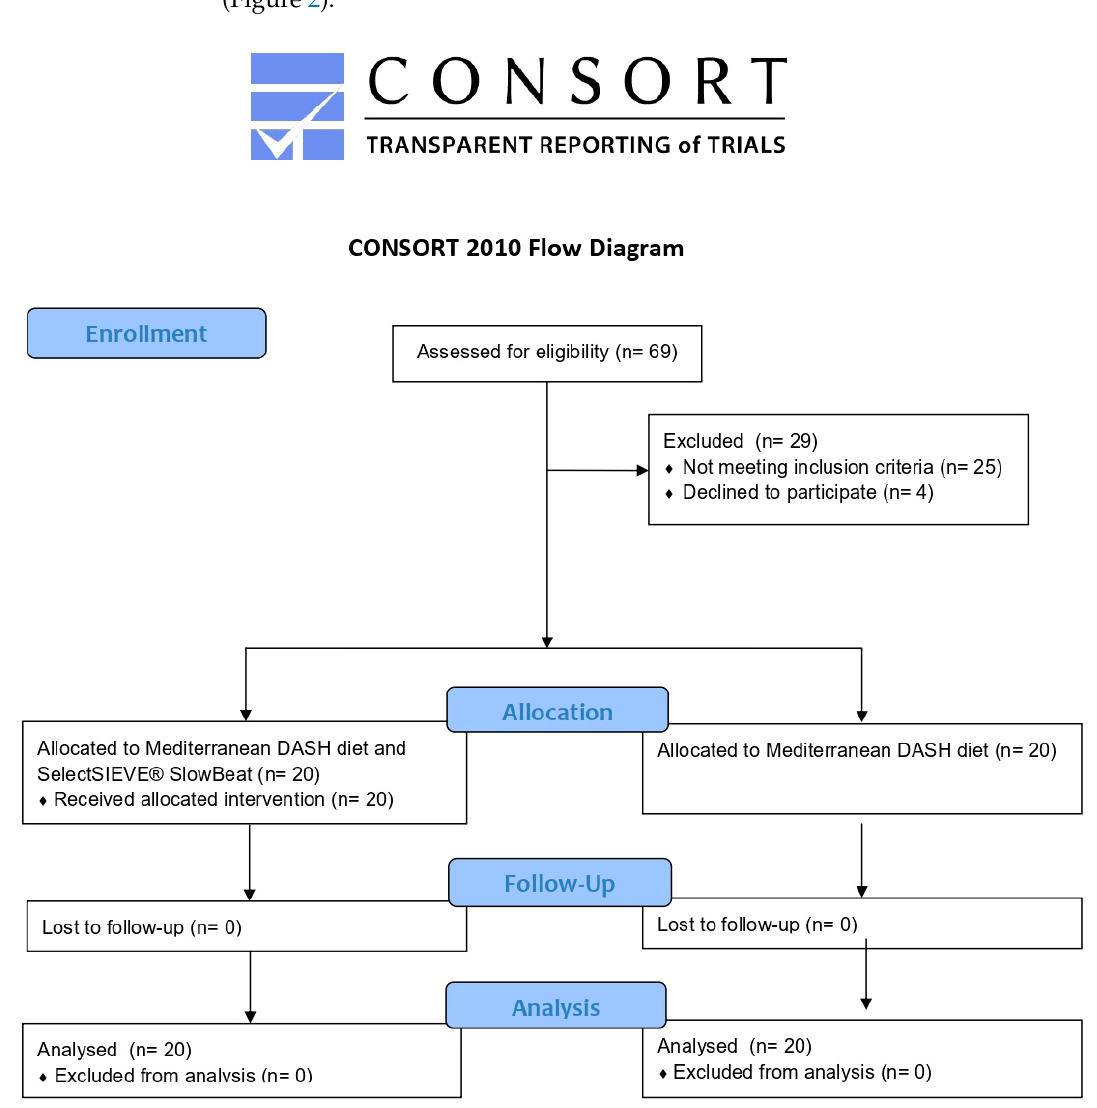
Figure 2. CONSORT (Consolidated Standards of Reporting Trials) flow diagram. At baseline, the groups were cross-matched in regards to age and the main anthropo- metric and hemodynamic parameters (Table